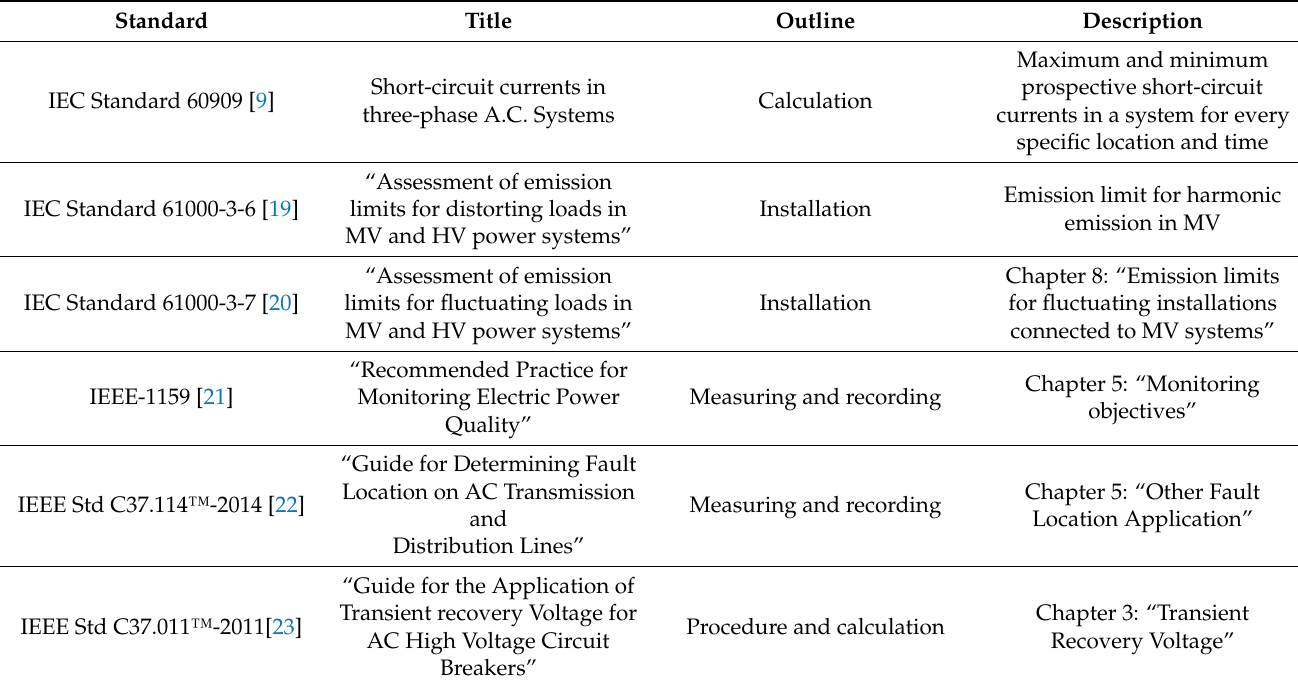
Figure 3. SAIDI by state in Peninsular Malaysia in 2017. Table 1. Recommended standard for fault